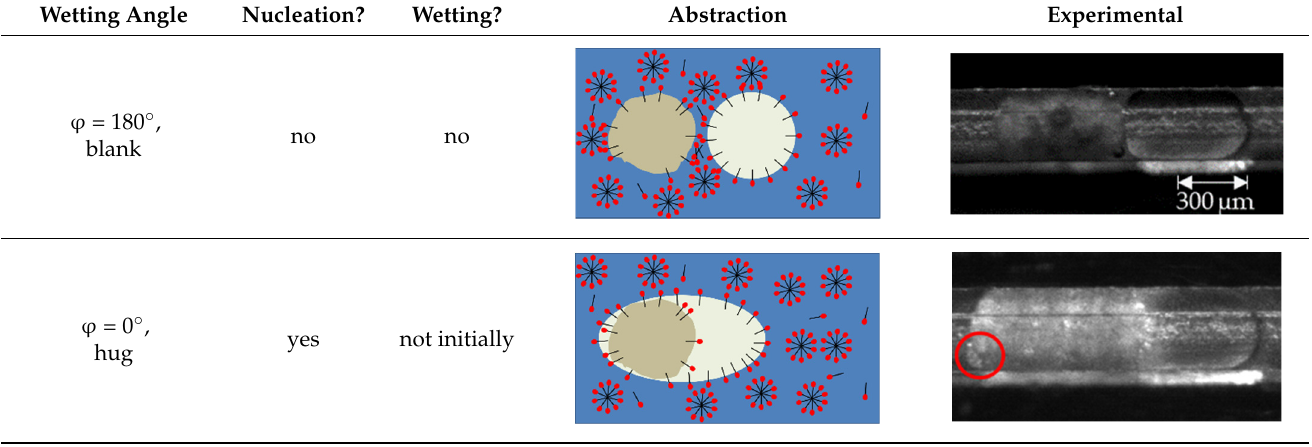
φ = 180°, ϕ = 180 ◦ , blank